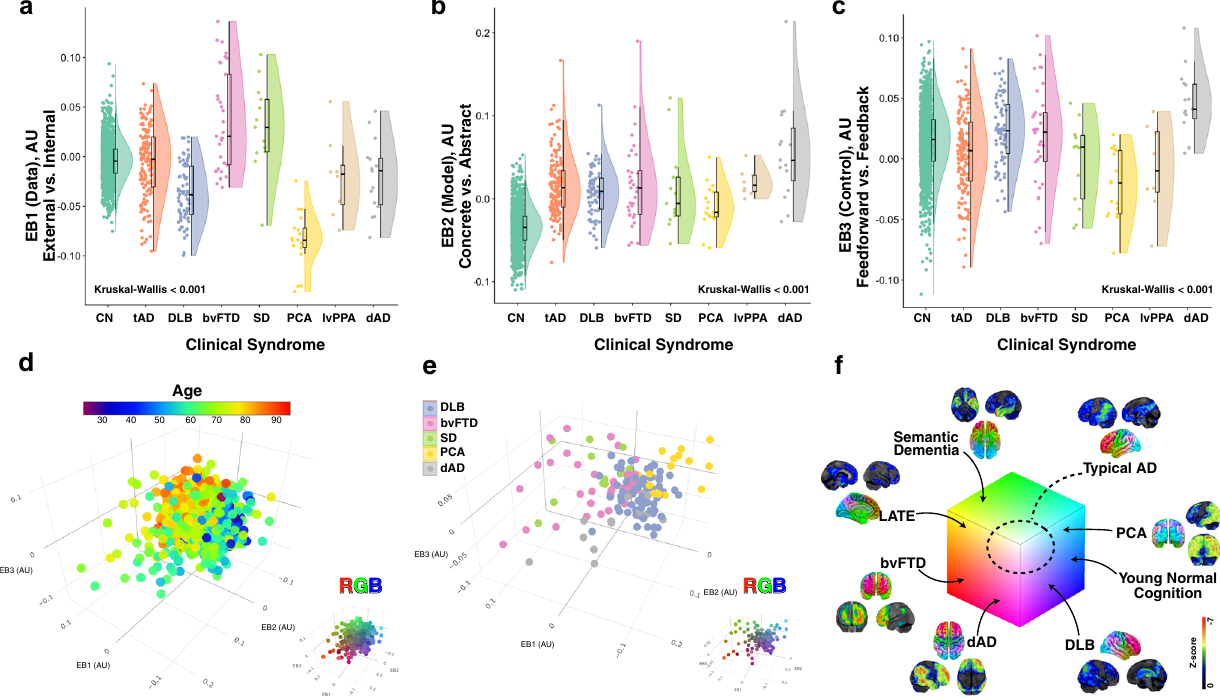
Fig. 4 Glucose eigenbrains across normal aging and seven clinical dementia syndromes. Rain cloud plots 61 with data distribution and jittered raw data points for biologically independent unique patient observations on either side of boxplots (horizontal lines denote median values; boxes extend from the 25th to the 75th percentile of each group ’ s distribution of values; vertical extending lines denote values within 1.5 interquartile range of the 25th and 75th percentile of each group) of eigenvalues for a EB1, b EB2, and c EB3 for cognitively normal amyloid negative individuals across the aging spectrum (CN, n = 1121), typical AD (tAD, n = 137), dementia with Lewy bodies (DLB, n = 72), behavioral variant of frontotemporal dementia (bvFTD, n = 33), sematic dementia (SD, n = 11), posterior cortical atrophy (PCA, n = 15), logopenic variant of primary progressive aphasia (lvPPA, n = 8), and dysexecutive AD (dAD, n = 15). Source data are provided as a Source Data fi le. d Scatter plot for the fi rst 3 EBs for all these subjects with age color mapping showing the youngest individuals (blue) at the opposite extreme from the oldest individuals (red). The same plot with RGB color mapping for reference to other fi gures is inset in the bottom right. e Scatter plot for the fi rst 3 EBs for 5 dementia syndromes highlighting the differential mapping across the manifold with clinical syndromes coinciding with predictions made by the functional mapping in Fig. 3. The same plot with RGB color mapping for reference to other fi gures is inset in the bottom right. f The same RGB color mapping used in Fig. 3 indicating the anatomy and state space location for each clinical group (including an example of limbic-predominant age-related TDP-43 encephalopathy [LATE] 46 ). A representative single subject clinical FDG-PET (Cortex ID, GE Healthcare, Chicago, IL, USA) with z -scores relative to age matched controls color-coding the degree of hypometabolism for one patient from each group is also displayed. AU-arbitrary